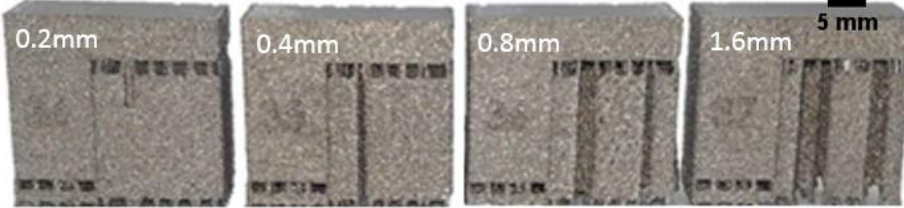
Figure 9. Support structures with various fragmentation separation widths.